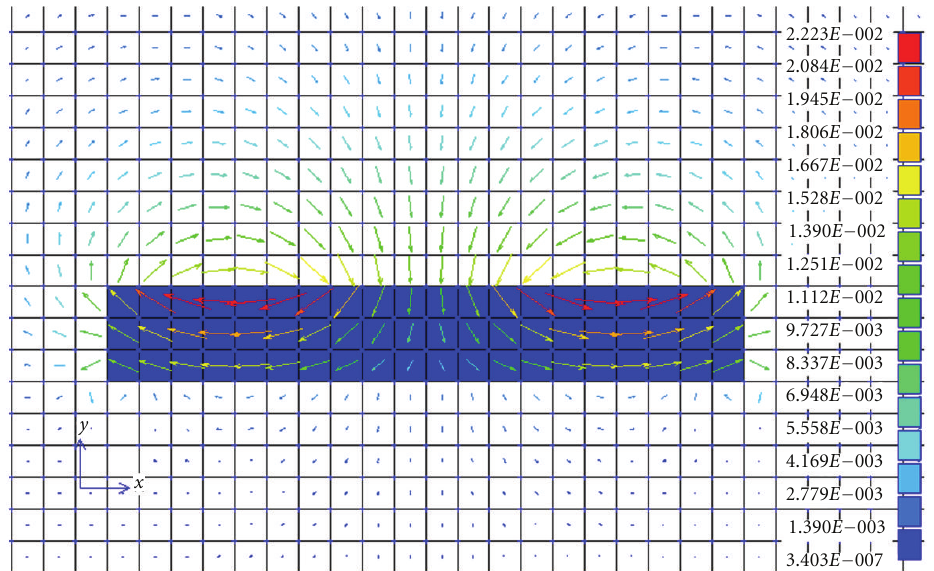
Figure 9: Analytical result of flux density after the magnetization in the opposite direction.